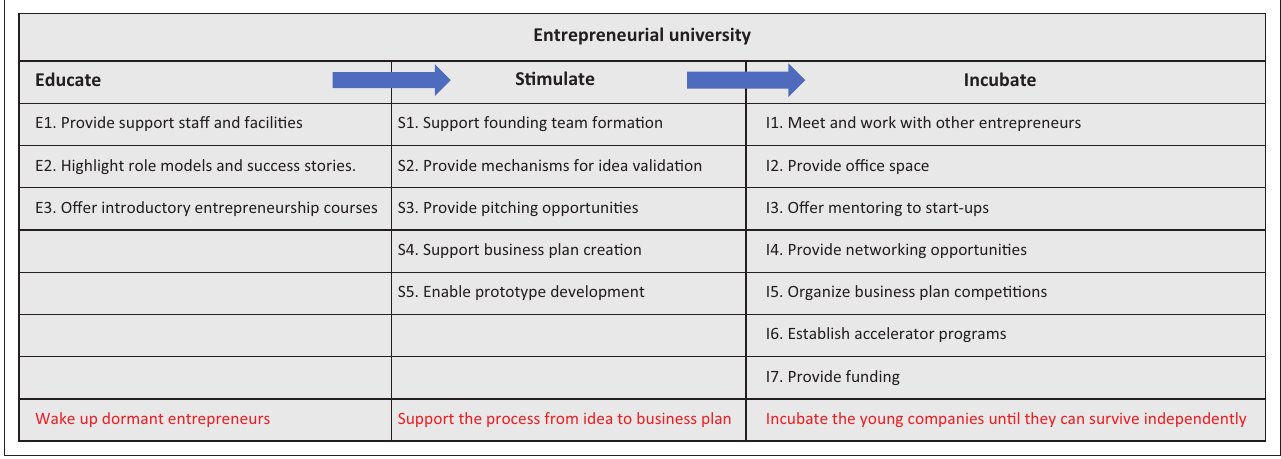
FIGURE 1: Three-stage student entrepreneurship encouragement